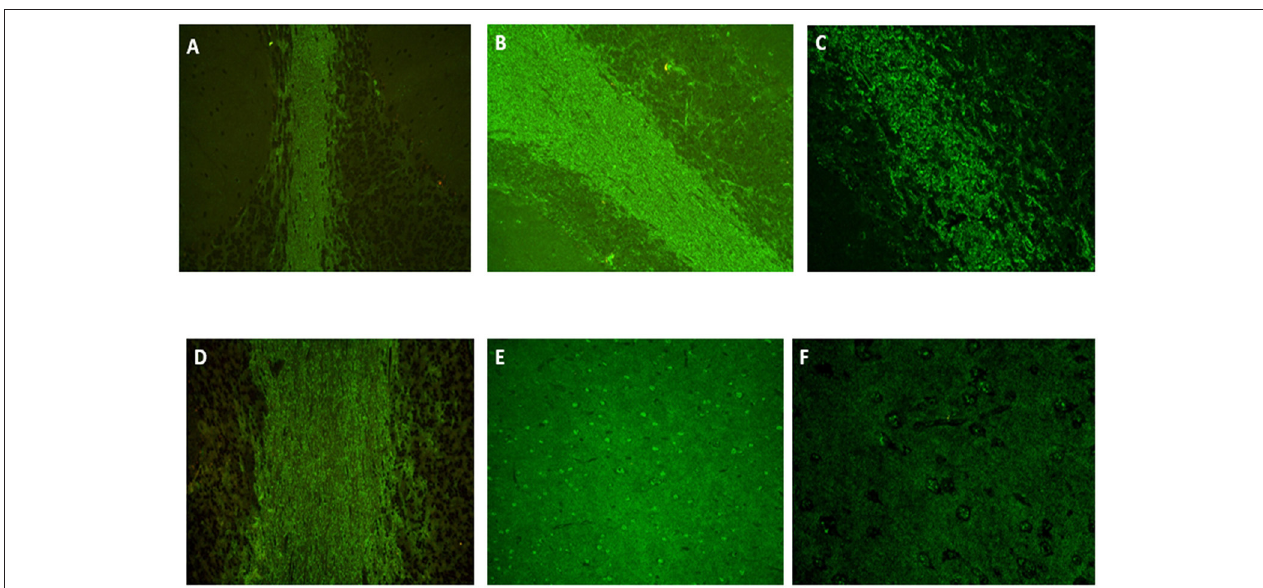
FIGURE 2 | Indirect immunofluorescence on monkey cerebellum slices (ref. 0665042225.10, NOVA Lite, Inova, Falls Church, USA) showing atypical and intense staining of the white matter for patient N ◦ 1 [ (A) , × 20, IgM kappa monoclonal gammopathy], identical when a secondary antibody anti-IgG, anti-IgM or anti-kappa was used but negative with an anti-lambda antibody. The same staining was found for patient N ◦ 2 with anti-IgG [ (B) , × 20], anti-IgM and anti-lambda [ (C) , × 40, IgM lambda monoclonal gammopathy] but negative with anti-kappa. Patient N ◦ 3 (IgG kappa monoclonal gammopathy) had a positive staining only with anti-IgG and anti-kappa secondary antibody [ (D) , × 20]. A fine speckled staining was also present in cortex [ (E) , × 20 and (F) , × 40] for all patients. Immunostaining positivity was only present within sera but negative within CSF. Anti-MAG antibodies presence was tested on monkey nerve slice (ref. 066504210.10, NOVA Lite) and confirmed by ELISA (ref. EK-MAG, Bühlmann, Bremen,